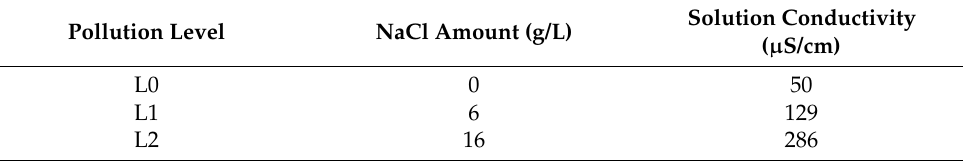
Table 1. Information about salt amount and conductivity of artificial pollution levels L1 and